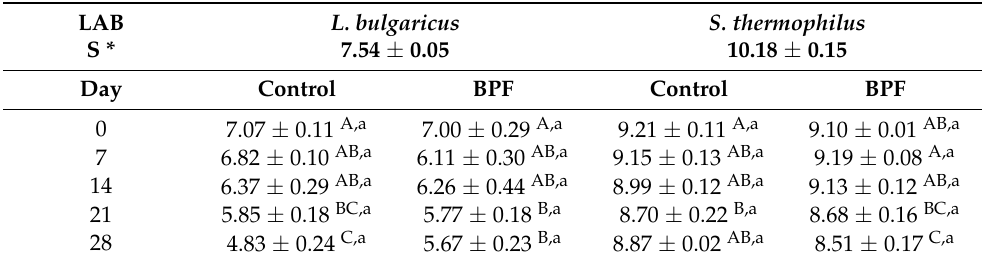
Table 2. Viable counts (log CFU/mL) of S. thermophilus and L. bulgaricus in yogurts prepared by applying starter cultures (control) and granulated BPF as a premix. LAB L. bulgaricus S. thermophilus S * 7.54 ± 0.05 10.18 ± 0.15 Day Control BPF